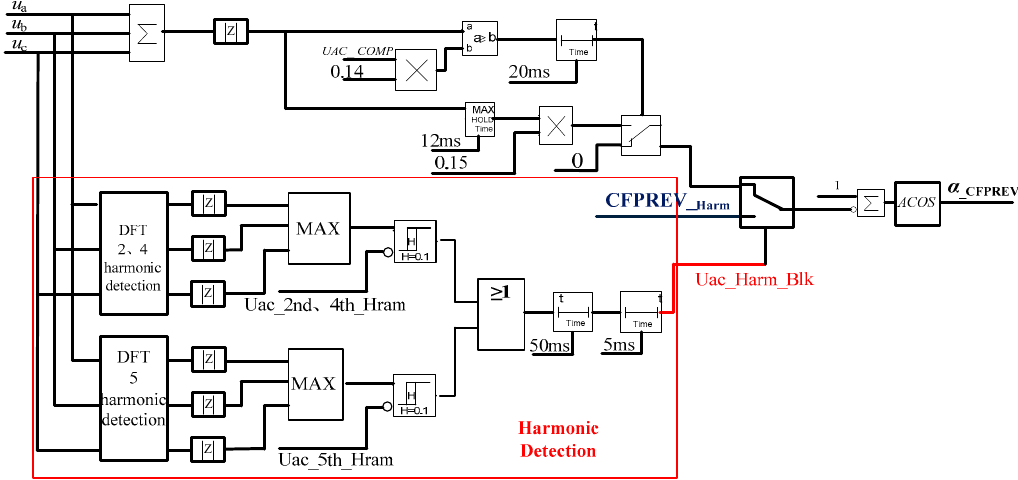
Figure 9. A simplified logic diagram of the new commutation failure prediction method to protect against transformer excitation surge current.